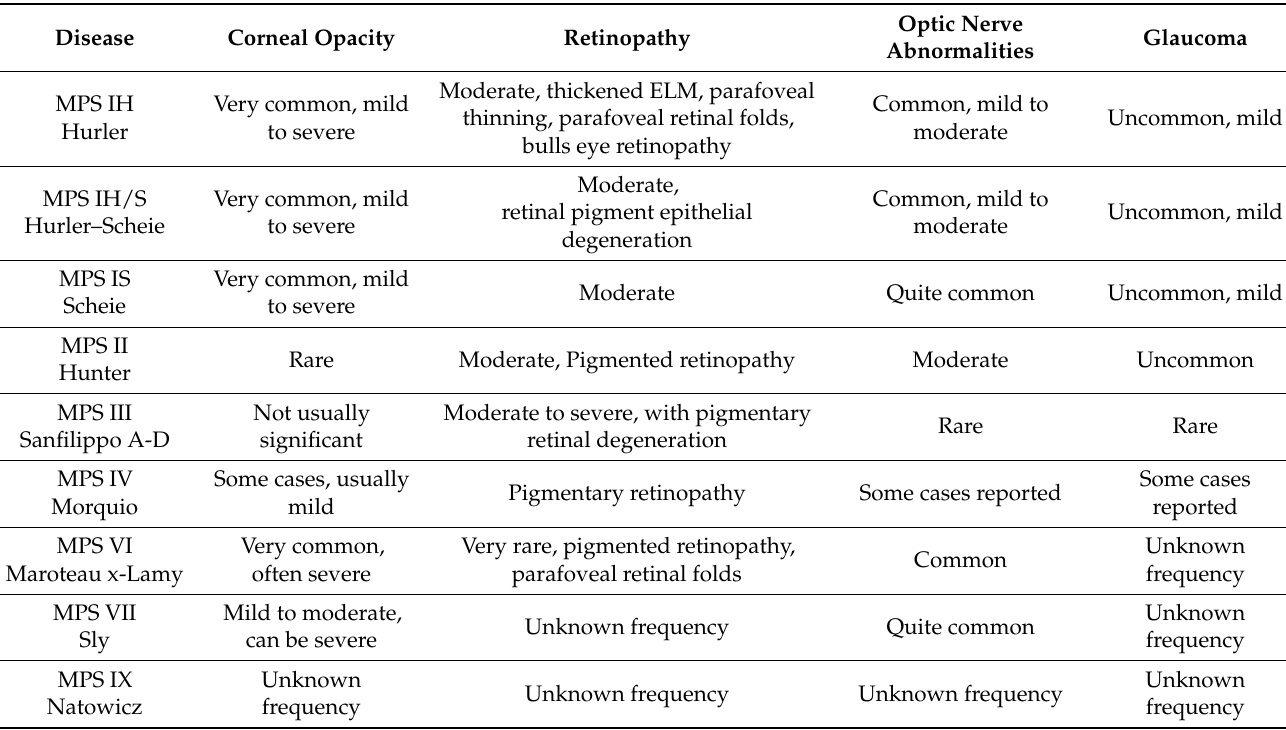
Table 1. Ocular findings in patients with mucopolysaccharidoses. Data from Ashworth et al. [1]. Disease Corneal